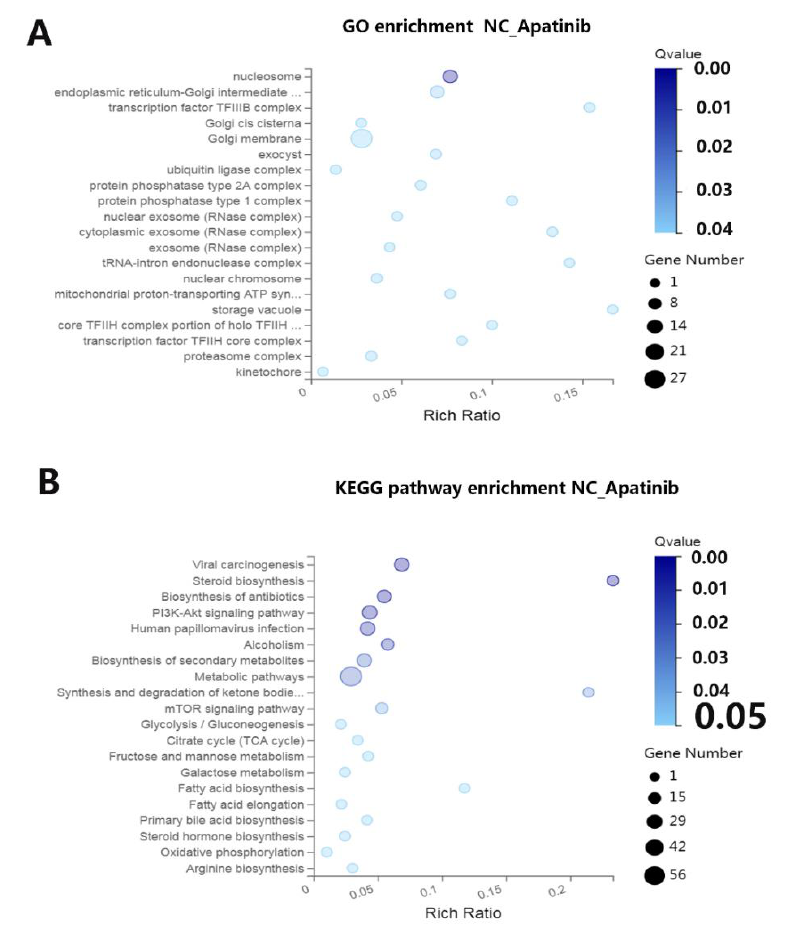
Figure 3. Functional analysis of the differentially expressed genes. ( A ) Gene ontology (GO) enrich- ment and ( B ) Kyoto Encyclopedia of Genes and Genomes (KEGG) pathway enrichment analysis of differentially expressed genes between the control group and apatinib